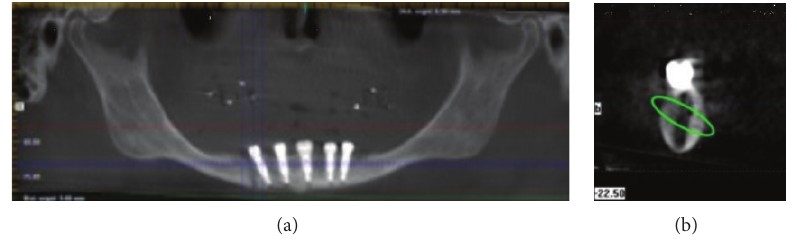
Figure 11: The CBCT (a) and a slice (b) where the hairline fracture is evident.